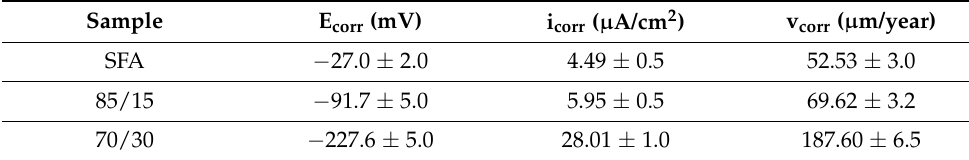
Table 2. Corrosion test